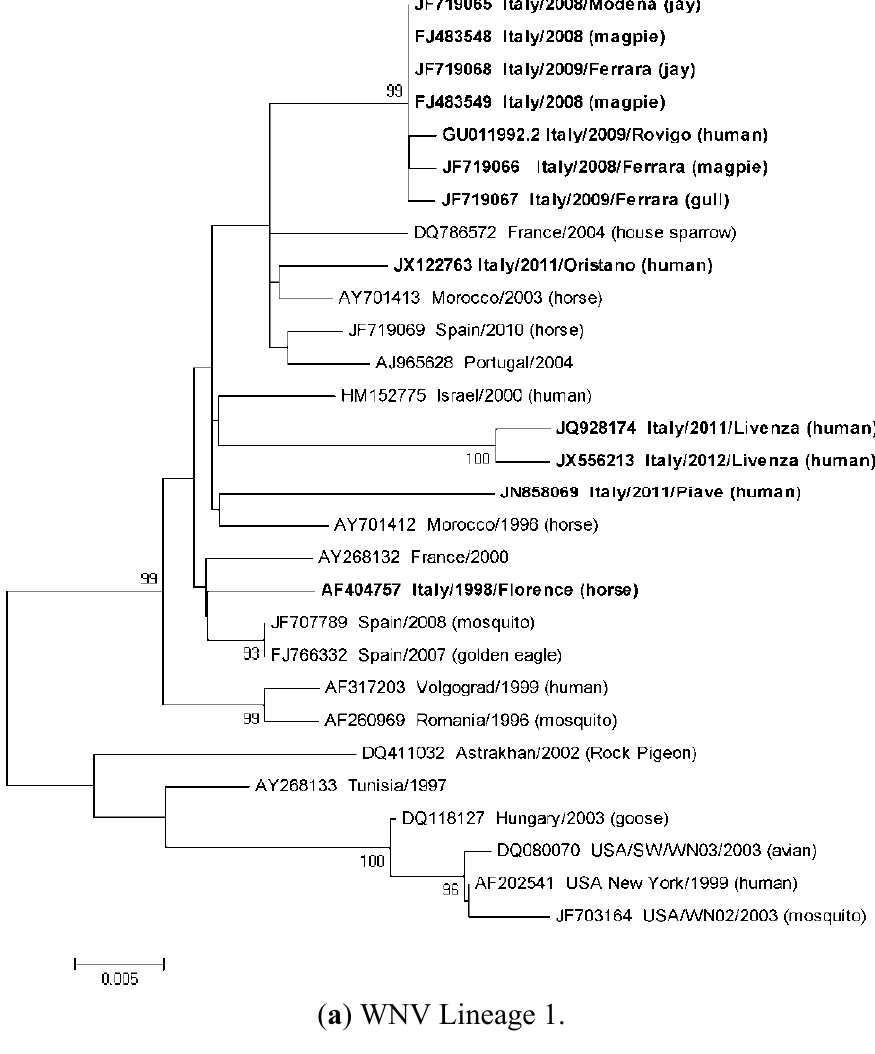
3’UTR sequences (357 nucleotides). The tree with the highest log